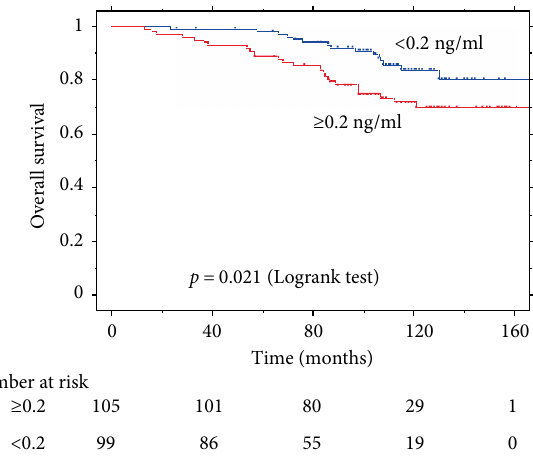
Figure 3: Kaplan–Meier survival curve of OS by pre-RT PSA. Figure 1: Kaplan–Meier survival curve of PSA-PFS by pre-RT